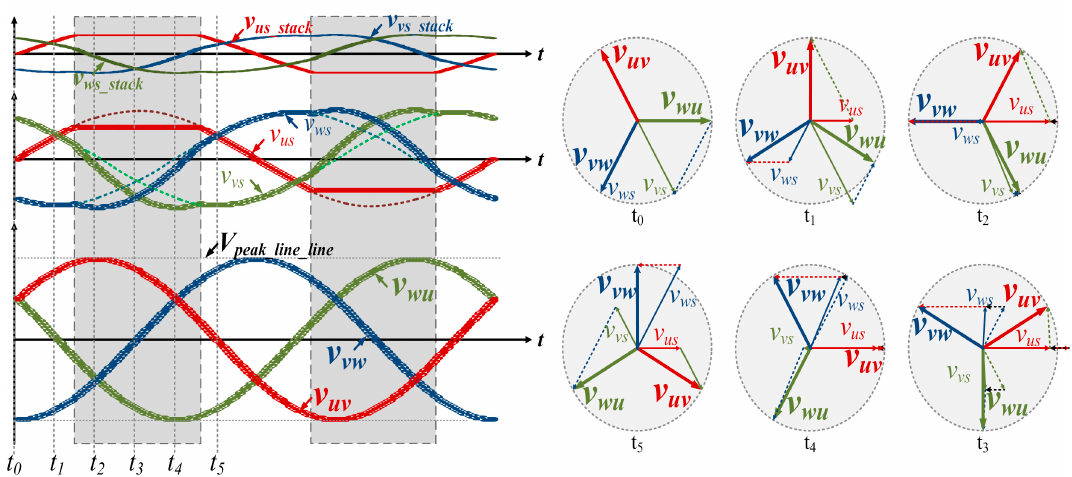
Figure 7. Time-dependent characteristics of proposed neutral-point voltage-shifting control.